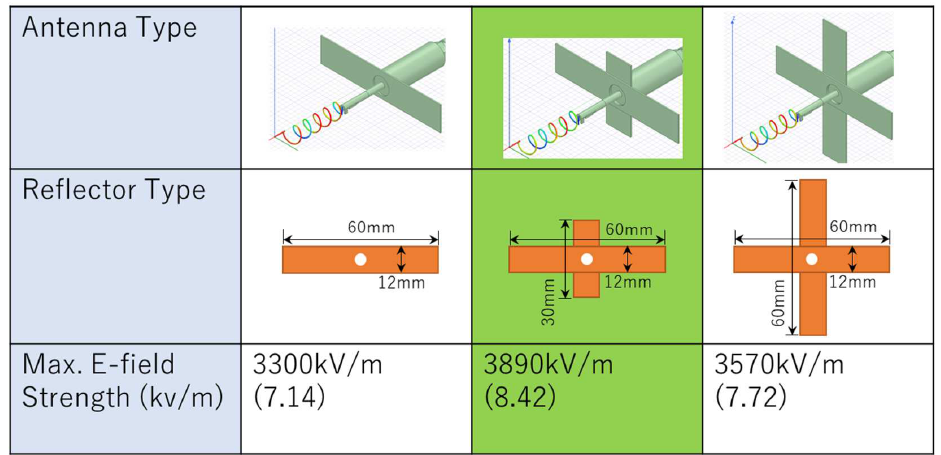
Figure 9. Antenna reflector design and corresponding electric field strengths.